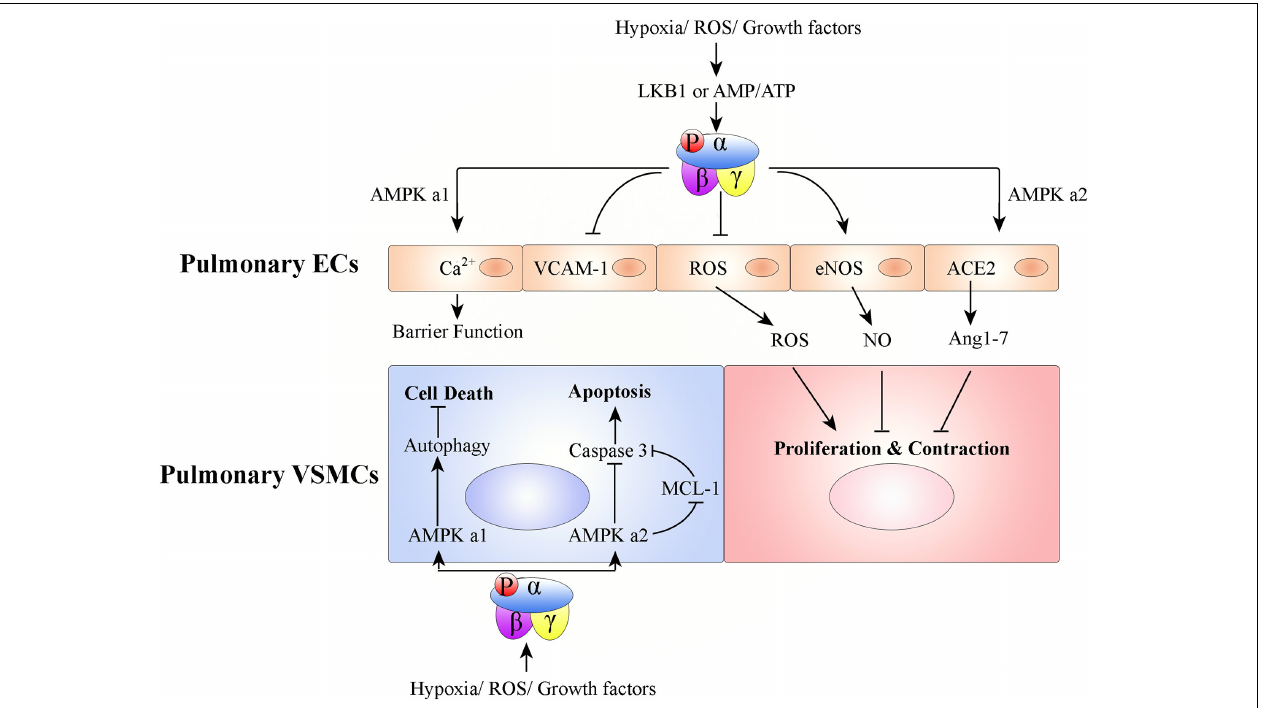
FIGURE 3 | Graphical summary of possible mechanisms associated with how AMPK activation affects pulmonary vascular remodeling. Hypoxia/ROS/growth factors activate AMPK in ECs or VSMCs to promote or inhibit PH development. In pulmonary ECs, AMPK activation protects PH: (1) AMPK α 1 activation in pulmonary ECs promotes Ca 2 + influx to maintain endothelial barrier function, (2) pulmonary endothelial AMPK inhibits VCAM-1 expression to antagonize inflammatory cell infiltration, (3) AMPK activation in pulmonary ECs inhibits ROS production, promotes eNOS-NO bioactivity, and stabilizes ACE2 to increase Ang 1–7 expression. Pulmonary VSMC proliferation and contraction are thus regulated. In pulmonary VSMCs, AMPK α 1 activation promotes autophagy-mediated cell survival; AMPK α 2 activation inhibits cell